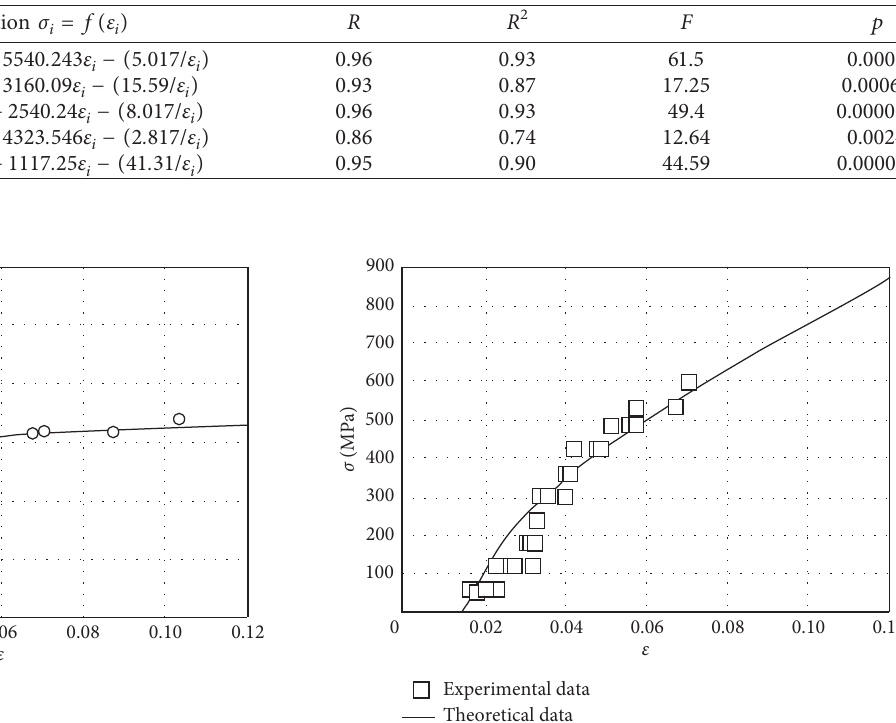
Figure 9: The dependence between the average value of micro- plastic deformation and the applied tensile stress in the deposited samples of steel C25 in the normalized state (group A).